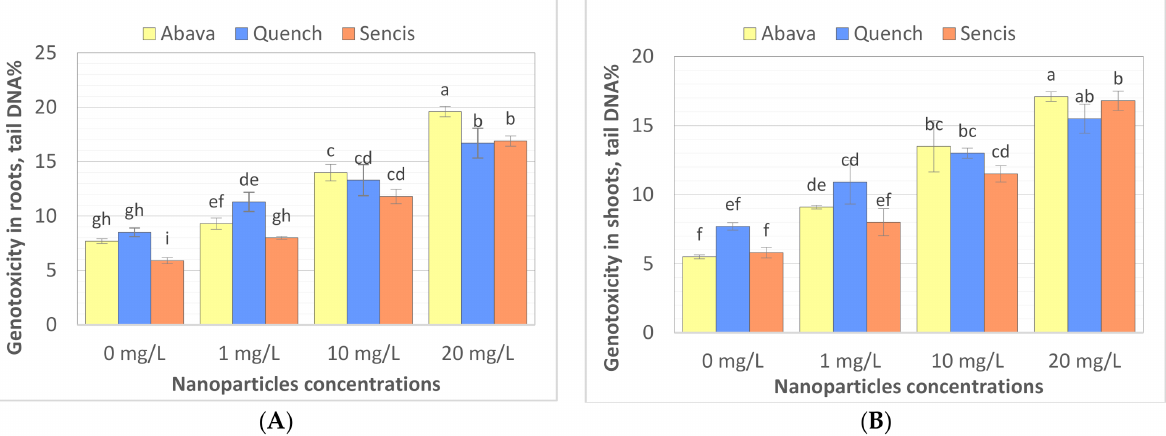
Figure 5. Evaluation the effect of Fe 3 O 4 nanoparticles on barley genome DNA of three H. vulgare L. cultivars using comet assay for roots ( A ) and shoots. ( B ) Values are the mean of three replicates with SD. Different letters within each bar indicate significant differences at p < 0.05 and the same letters indicate no significant difference (Tukey’s test—two-way analysis of